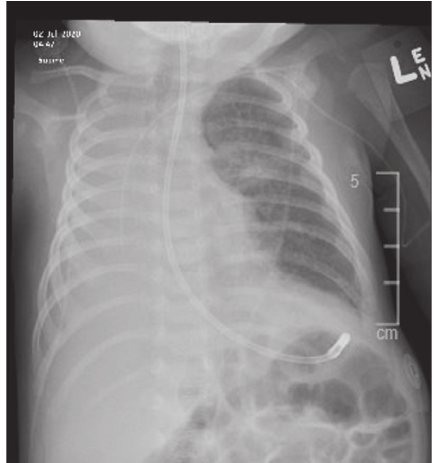
Figure 3: Chest X-ray showing new right lung